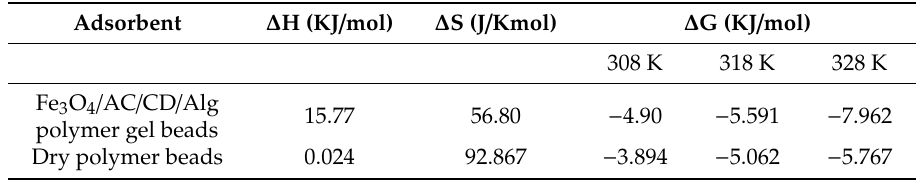
Table 5. Thermodynamic parameters for MB adsorption on Fe 3 O 4 / AC / CD / Alg polymer gel beads and dry powder beads.